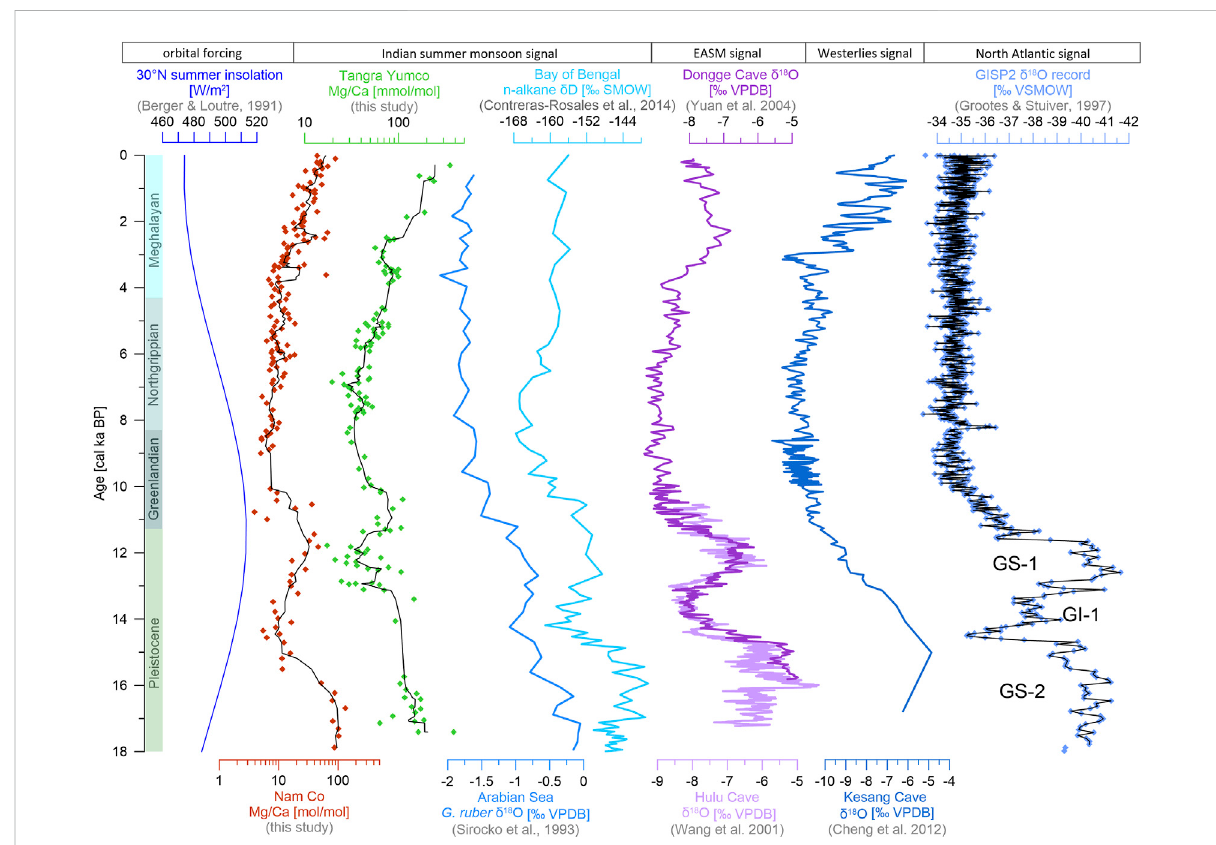
FIGURE 5 Moisture changes on the southern Tibetan Plateau based on Mg/Ca ratios of Leucocytherella sinensis shells from Nam Co and Tangra Yumco compared to Indian summer monsoon records from the Bay of Bengal (Contreras-Rosales et al., 2014) and Arabian Sea (Sirocko et al., 1993), East Asian monsoon records from Dongge and Hulu Cave stalagmites (Wang et al., 2001; Yuan et al., 2004), Westerlies record from Kesang Cave stalagmites (Cheng et al., 2012), as well as 30 ° N summer insolation showing orbital forcing (Berger and Loutre, 1991), the North Atlantic signal from the GISP2 δ 18 O record (Grootes and Stuiver, 1997). Solid black lines show 5-point smoothed data. The GISP2 record shows major climatic events in Greenland: Greenland Stadial 2 (GS-2, “ Heinrich 1 event ” ), Greenland Stadial 1 (GS-1, Younger Dryas chronozone) and Greenland Interstadial 1 (GI-1,